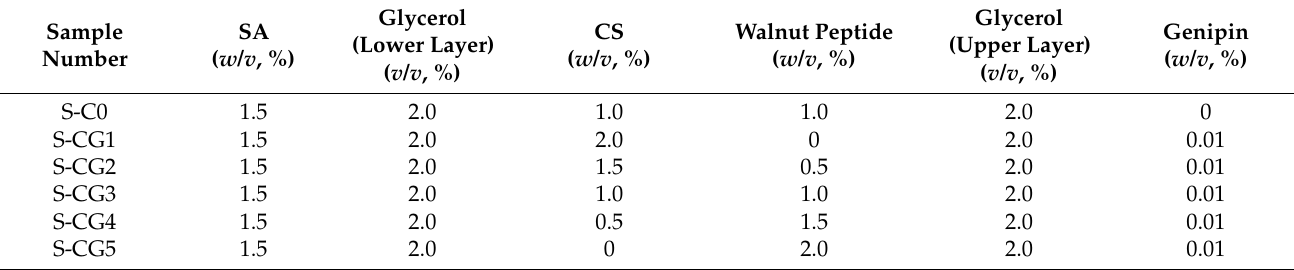
Table 1. Composition of different composite